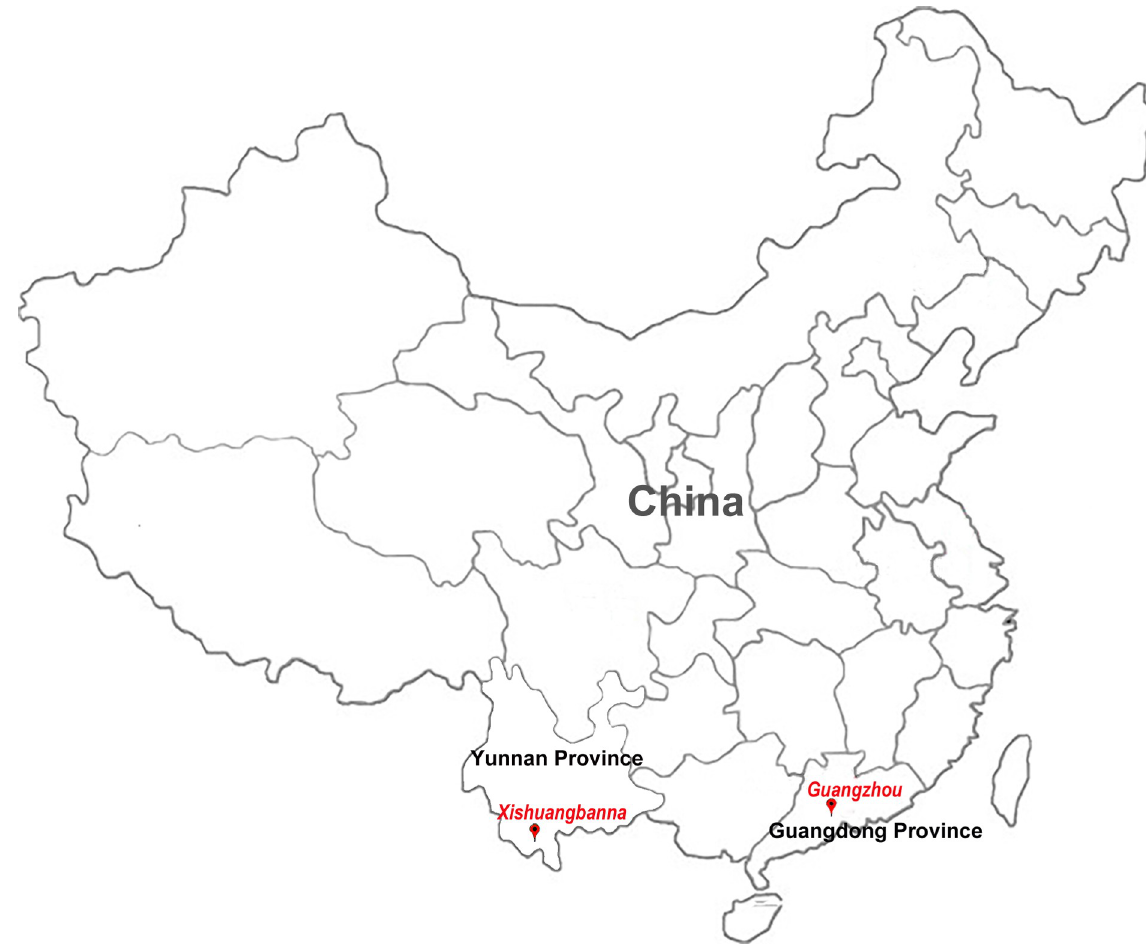
Fig 1. The location of the two study sites in China. Xishuangbanna, Yunnan province locate at southwest of China adjacent to Southeast Asian country and Guangzhou, Guangdong province locate at southern of China.